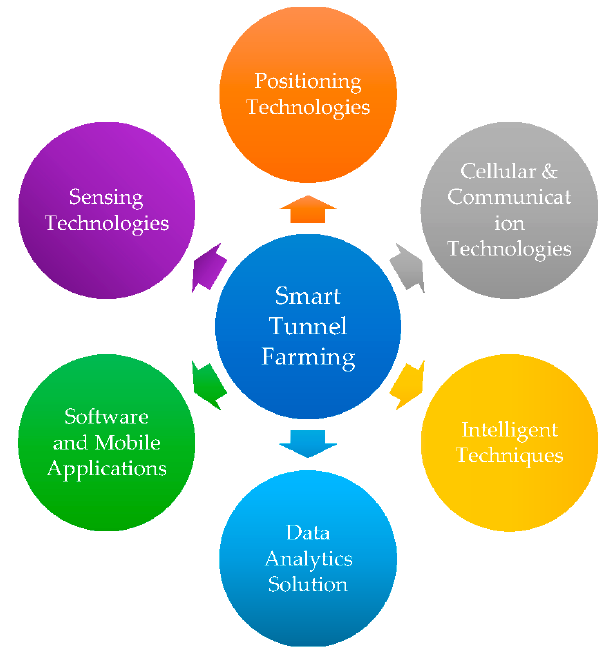
Figure 1. Important components of a smart tunnel farming system.